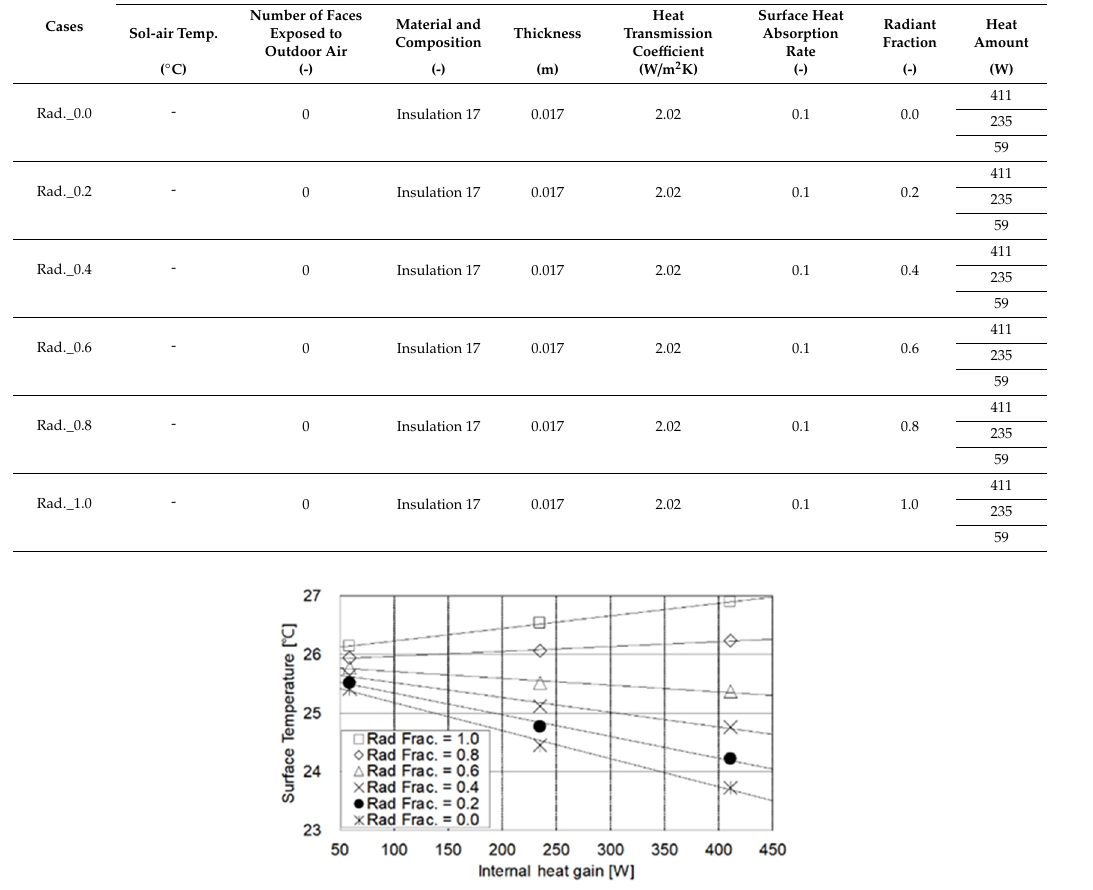
Figure 15. Scale of influencing factors.